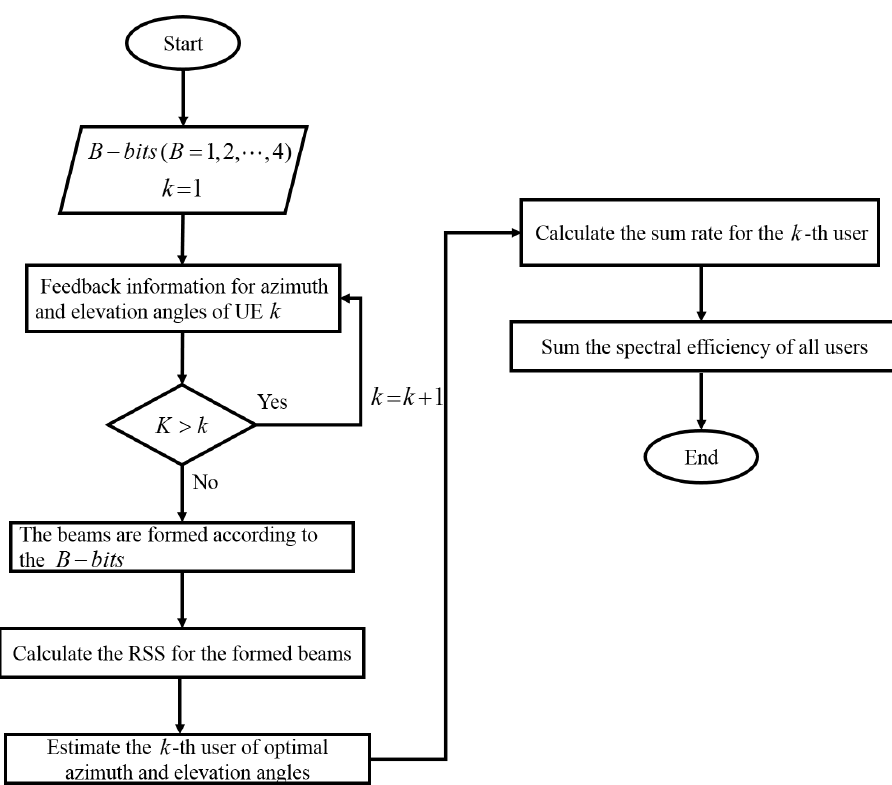
Figure 8. The flow chart for the proposed hybrid beamforming